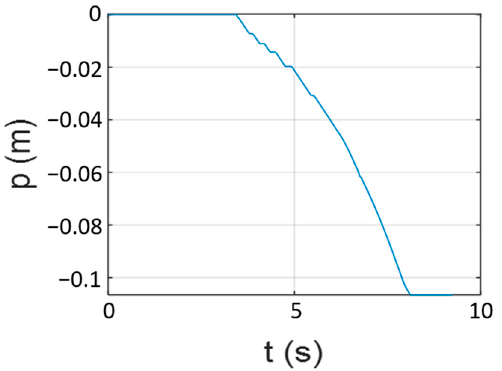
Figure 18. Distance adjustment for the robot to reach a proper location between the two customers.